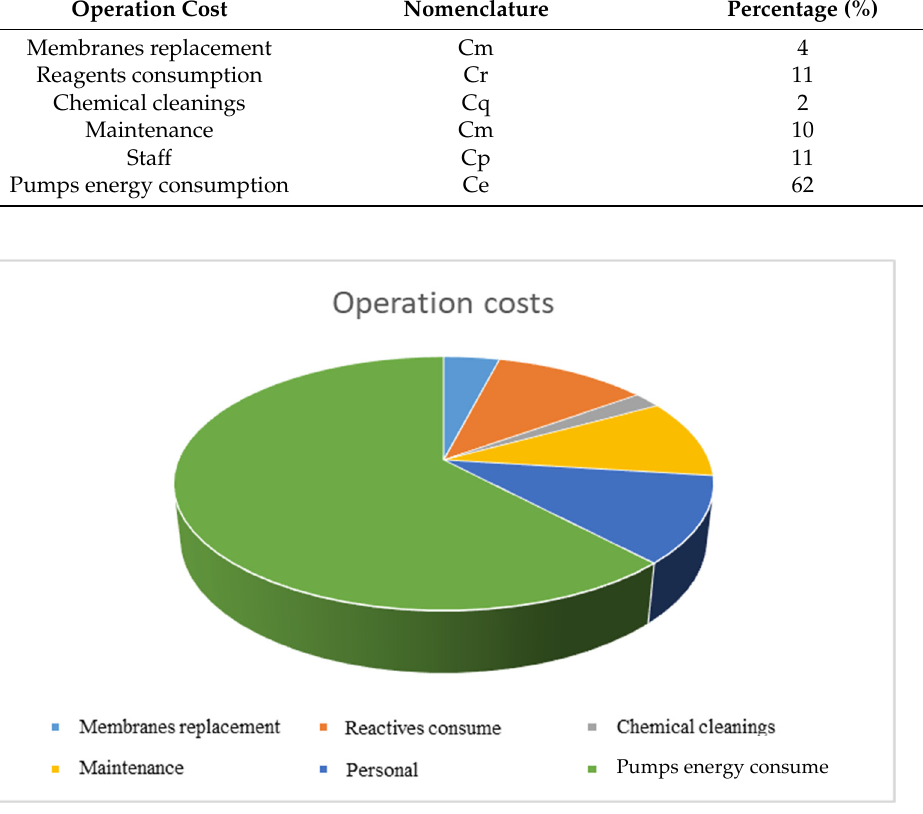
Figure 2. Operation costs.